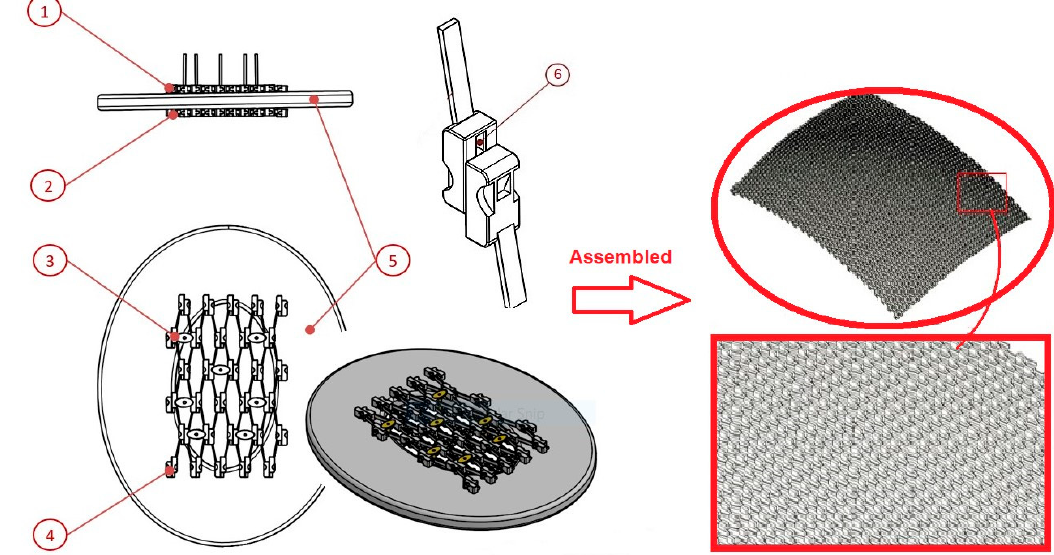
Figure 5. Left panel- Components of the cranial endoprosthesis with sliding system: Upper sliding layer ① ; lower sliding layer ② ; fixing system ③ . The sliding layers ① and ② are composed of multiple mobile cells with sliding system ④ ; Positioning of the stent in relation to a schematic model of the cranial box ⑤ ; Conjugate sliding system ⑥ . Right panel-The assembly of the mobile cells to obtain constructive anatomical curvature in order to facilitate customization.